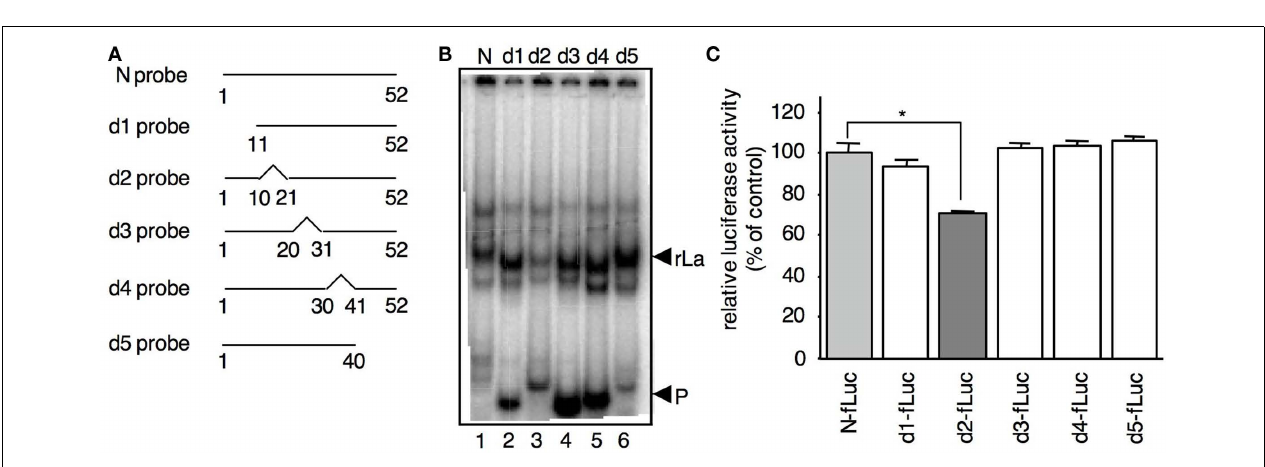
arrows. (C) Luciferase activity of B95a cells transfected with the reporter RNA containing various N-5 (cid:2) UTRs.The deletions indicated in (A) were introduced into N-fLuc (d1–d5-fLuc). c-rLuc was co-transfected as an internal control.The N-fLuc value was arbitrarily set at 100%. Statistical analysis was performed using the Student’s t -test; * P <